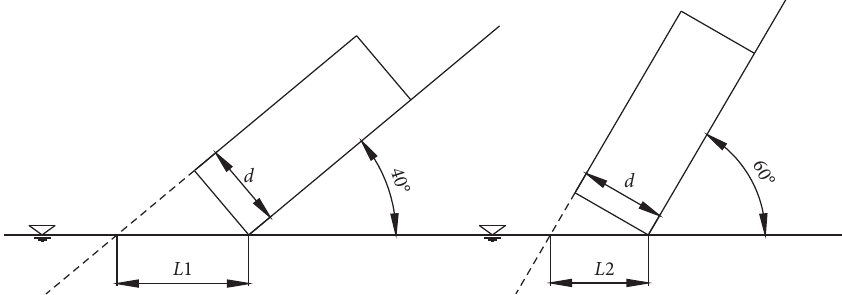
Figure 17: Water entry state of landslide mass under different slope angles.